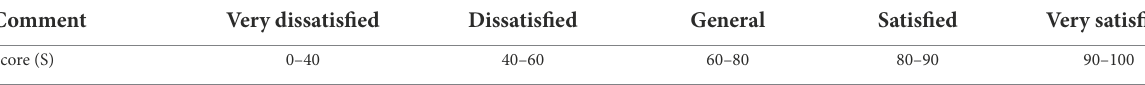
TABLE 4 Questionnaire score table.